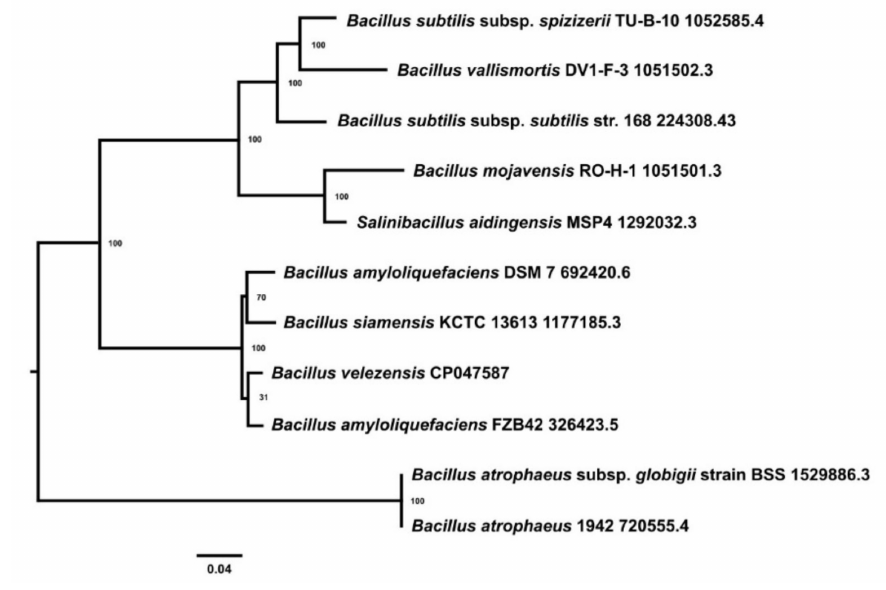
Figure 3. Phylogenetic Analysis of the Genome of Bacillus velezensis -VB7